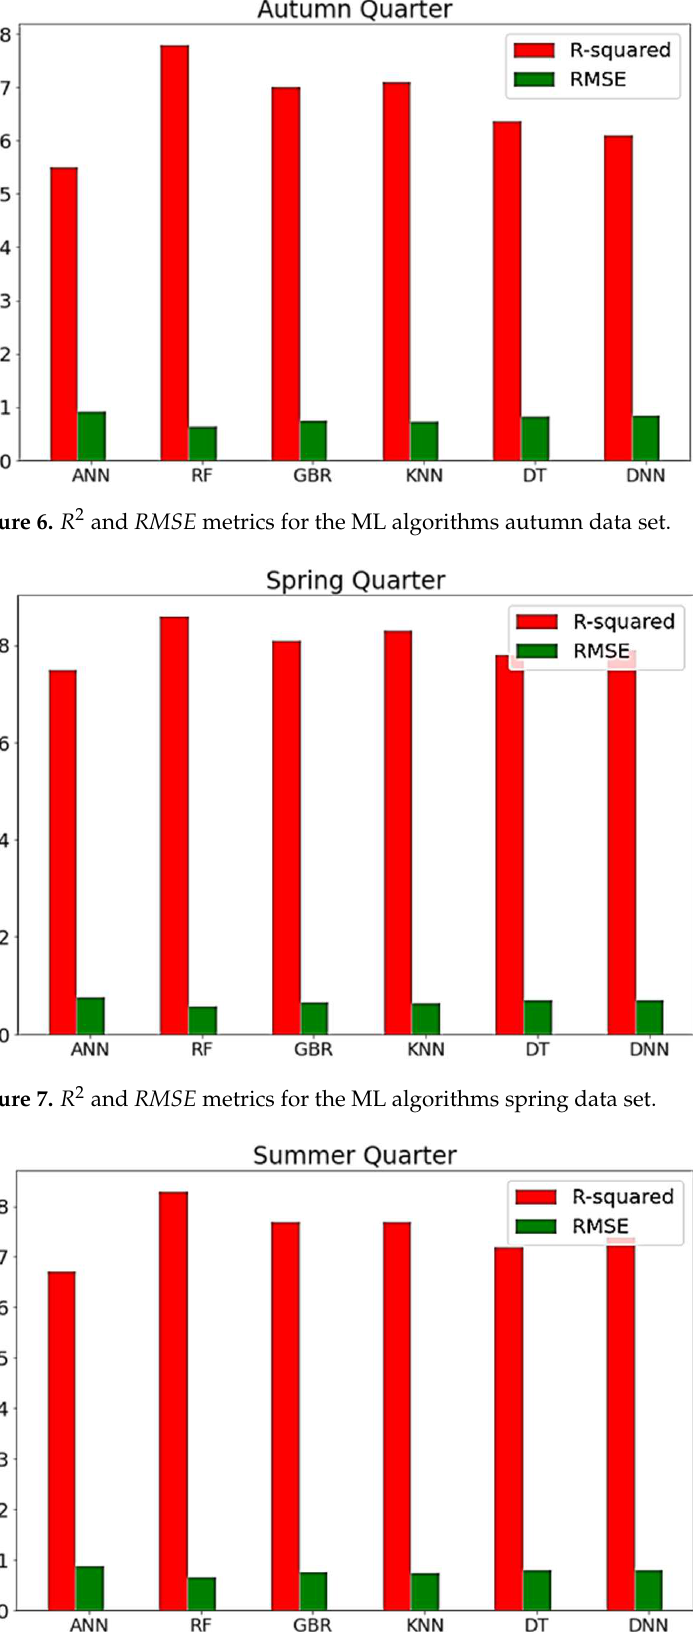
Figure 8. R 2 and RMSE metrics for the ML algorithms summer data set.